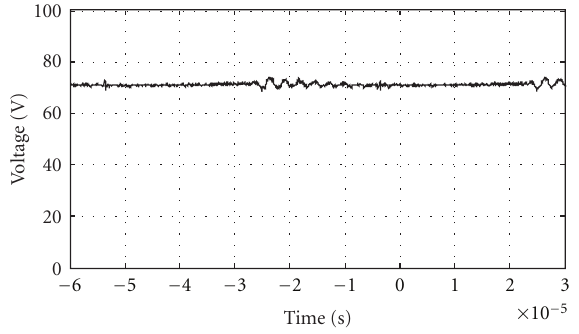
Figure 8: The output voltage of system with second order sliding mode.